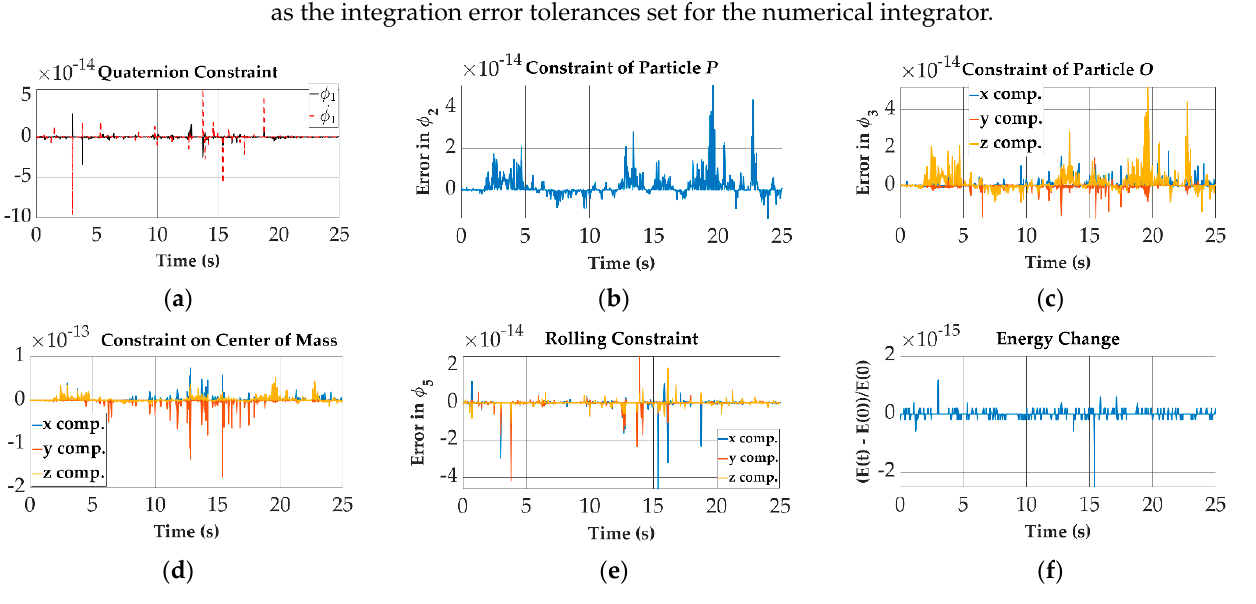
Figure 7. Example 1. Case A. Time history of the numerical errors in the satisfaction of the con- straints ( a ) . ϕ ( a ) ϕ 1 and , ( b ) ϕ 2 , ( c ) ϕ 3 , ( d ) ϕ 4 , ( e ) ϕ 5 , ( f ) normalized ϕ E 1